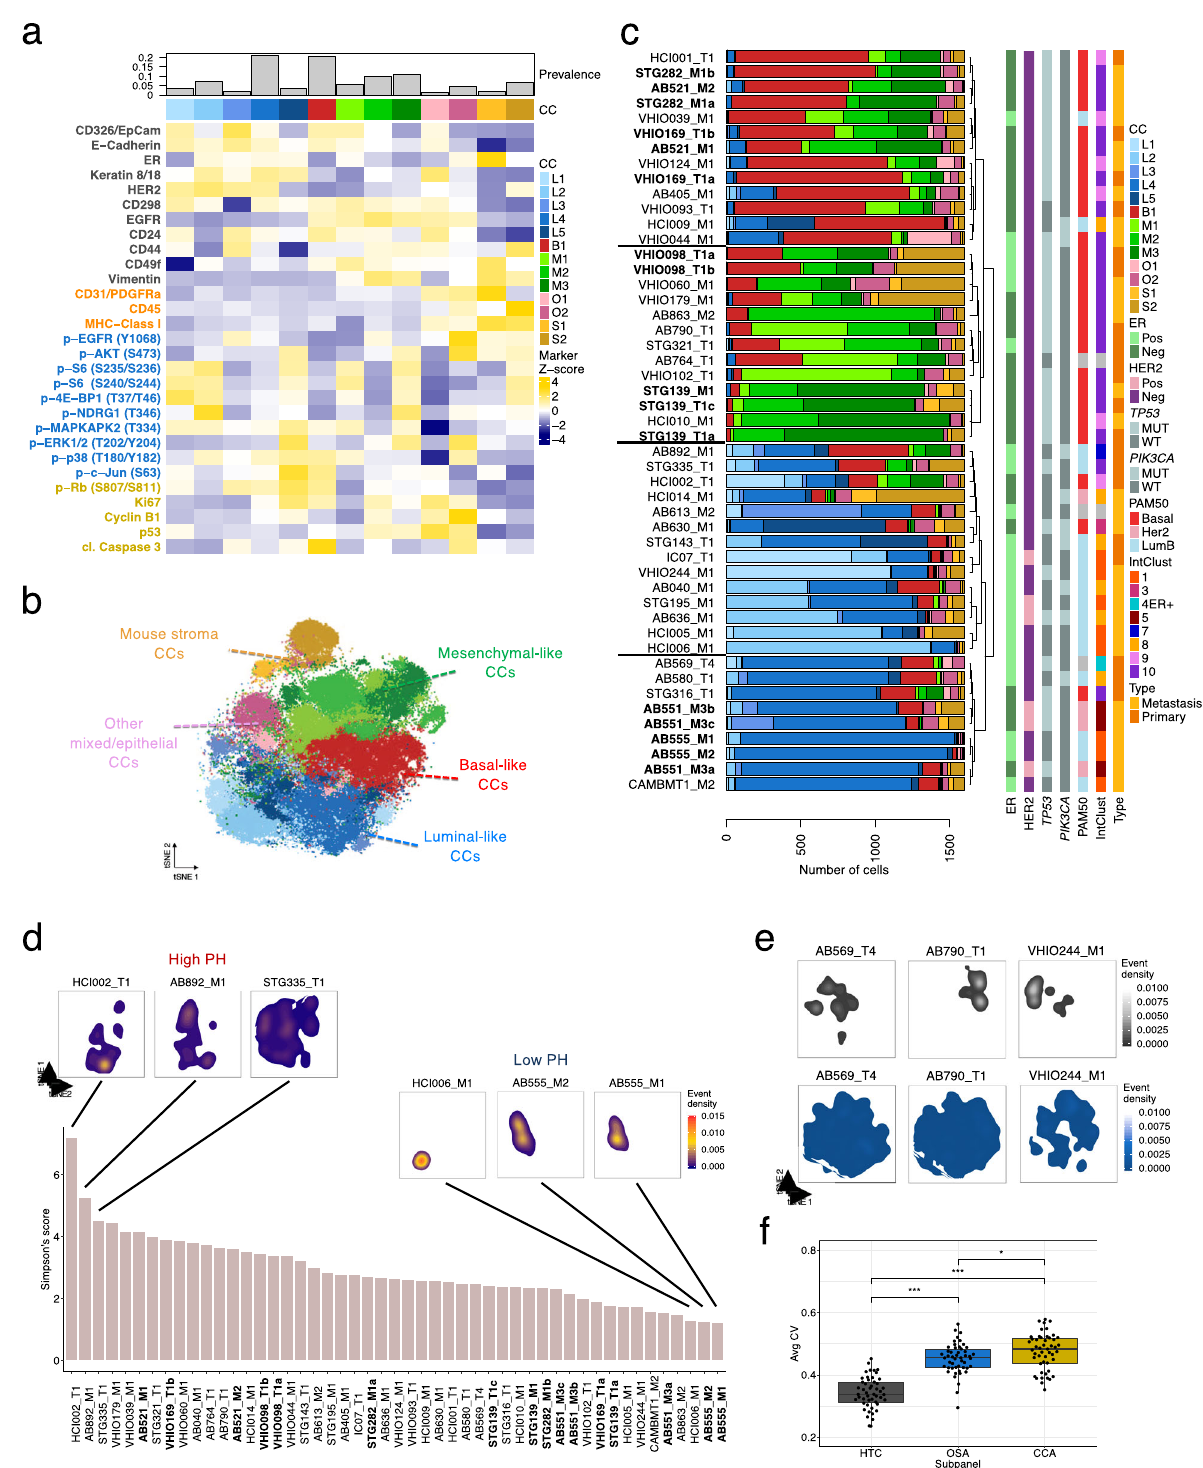
the highest expression of CD49f and EGFR. M2 and M3 cells also expressed low E-cadherin and EpCAM and high levels of Vimentin, suggestive of epithelial-to-mesenchymal transition (EMT) 39 . M1 cells had a pattern of marker expression and location on the tSNE map suggesting an intermediate state between basal-like and mesenchymal-like (Fig. 3a, b). M1-3 had similar human tumour marker expression but diverse oncogenic signalling